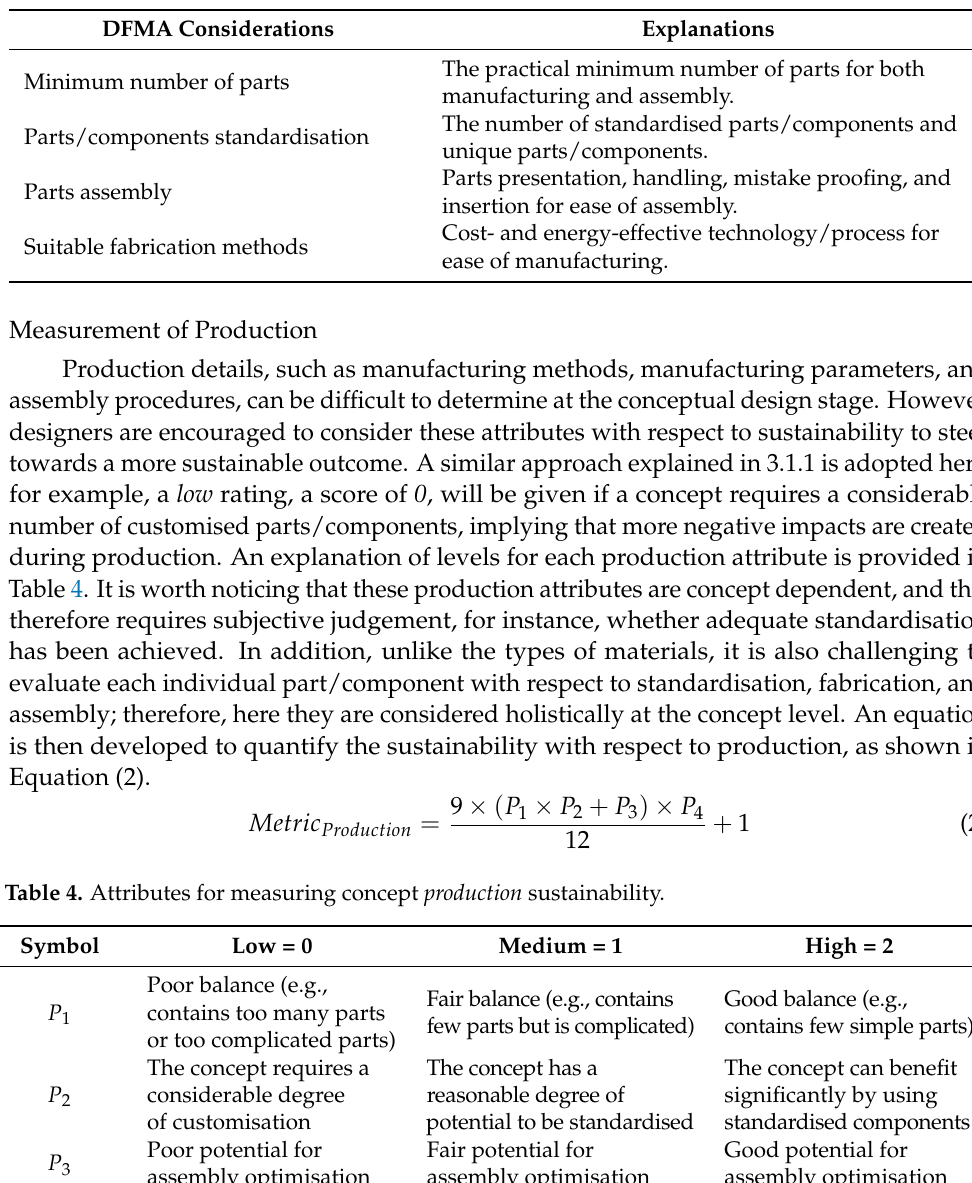
Table 3. DFMA considerations for sustainable product design concepts.